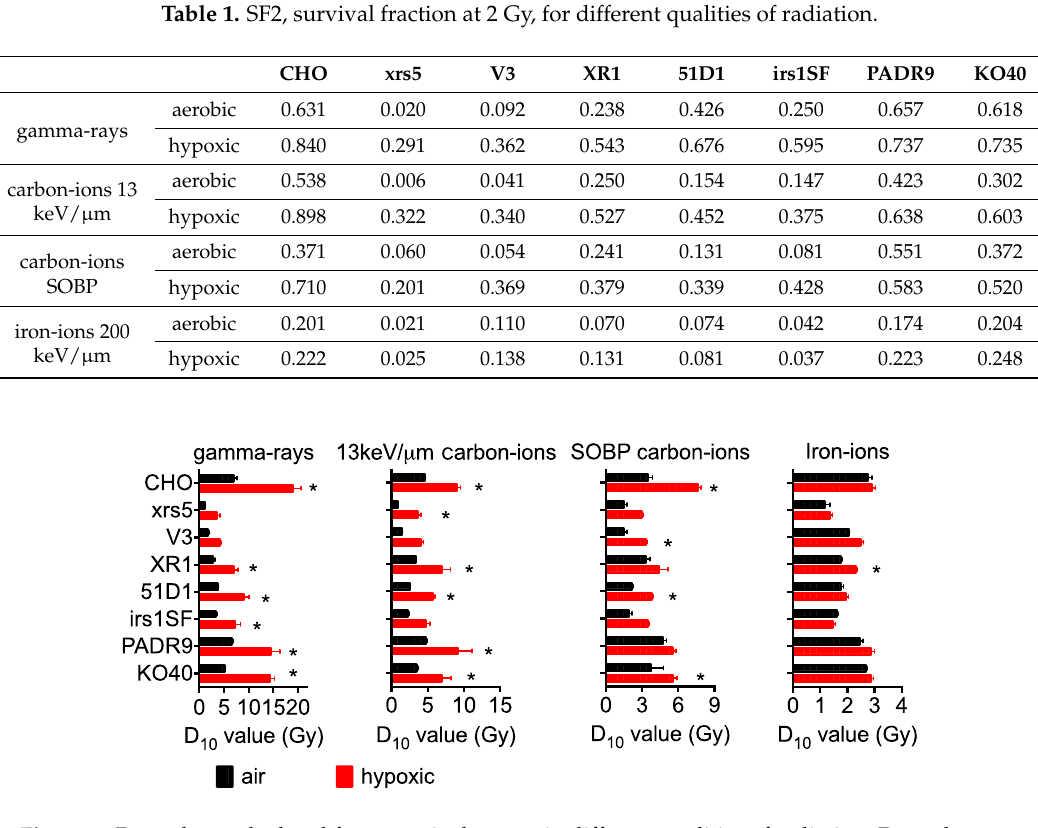
Figure 2. D 10 values calculated from survival curves in different qualities of radiation. D 10 values are the mean ± standard error of the means. * Indicates statistically significant differences between aerobic and hypoxic irradiation conditions ( p < 0.05).